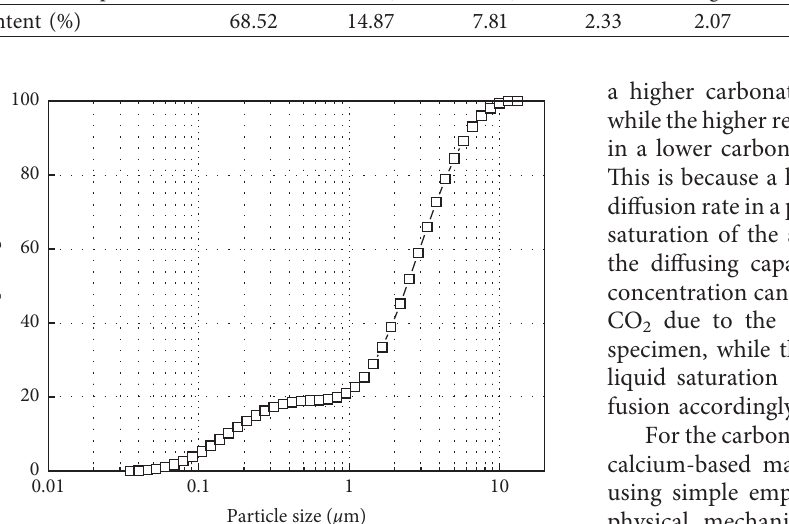
Figure 1: Particle size distribution of the tested soil.